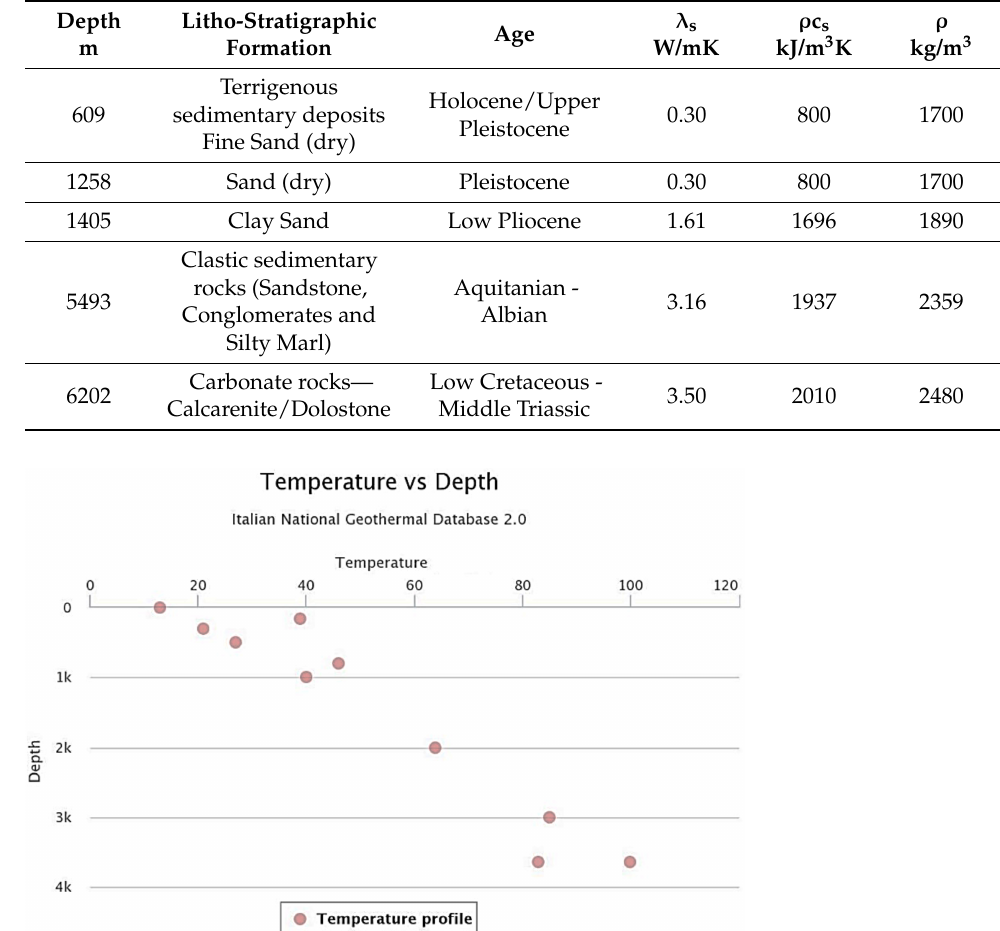
Table 1. Villafortuna 1 hydrocarbon well-lithostratigraphic profile (Villafortuna Trecate Oilfield, Western Po Plain).